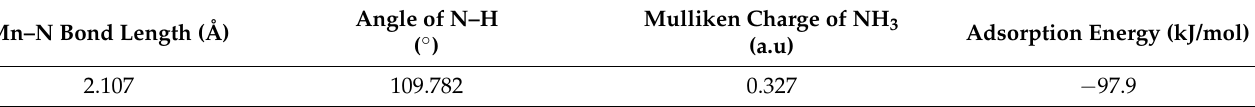
Figure 3. The partial density of state for NH 3 adsorption configuration.